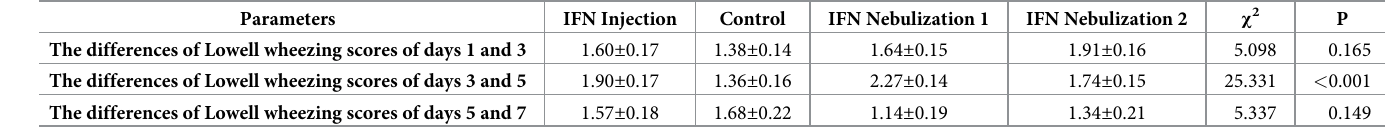
Table 8. The comparisons for the differences in the Lowell wheezing scores among the four groups by the Kruskal—Wallis test. Parameters